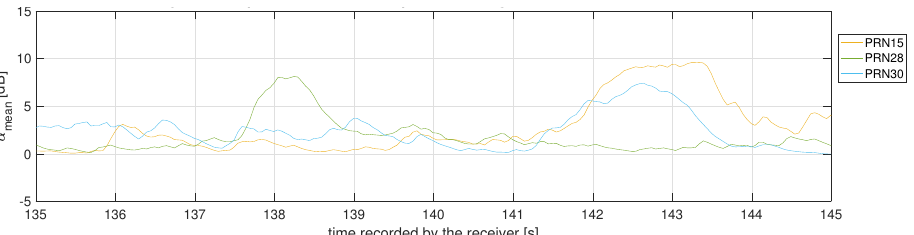
Figure 10. Example of river width detection taken from data set (1).